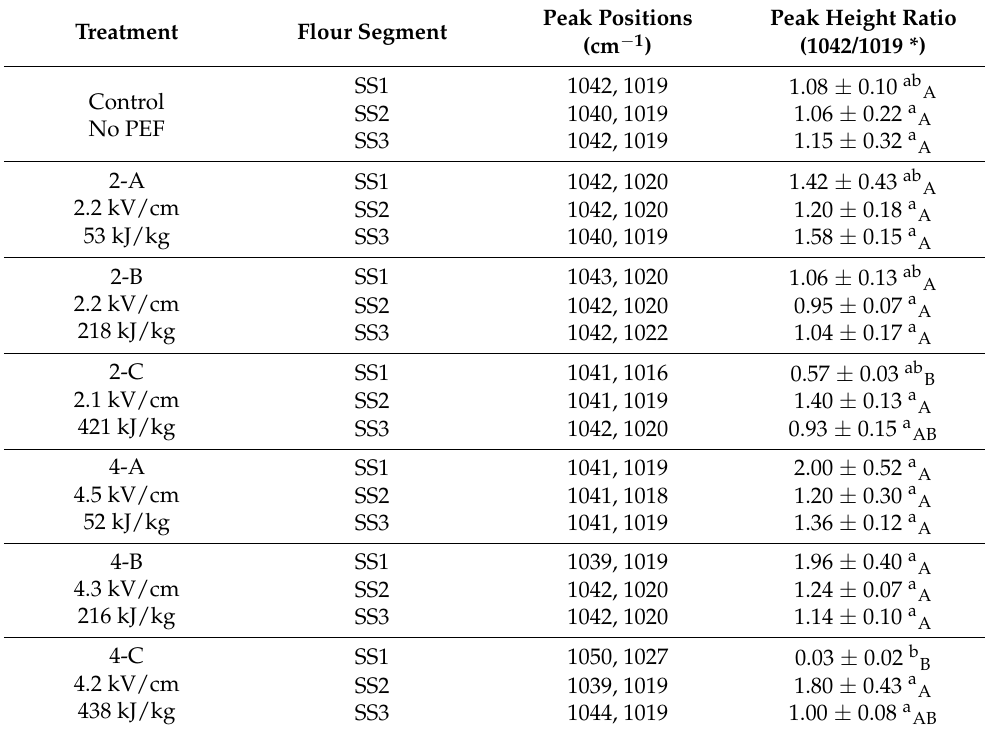
Table 3. Ratio of the crystalline to amorphous regions of starch in three different flour segments that were collected after PEF treatment of oat